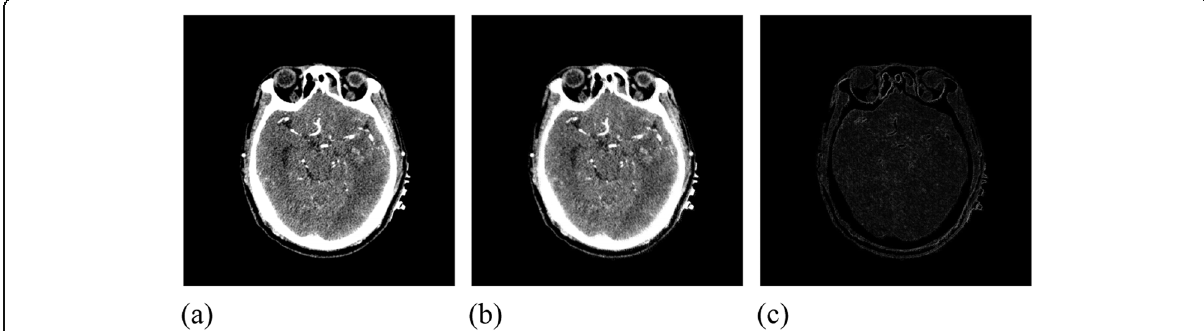
Fig. 18 Initial image data. ( a ): CT reference image; ( b ): CT moving image; ( c ): Difference between CT reference image and moving image